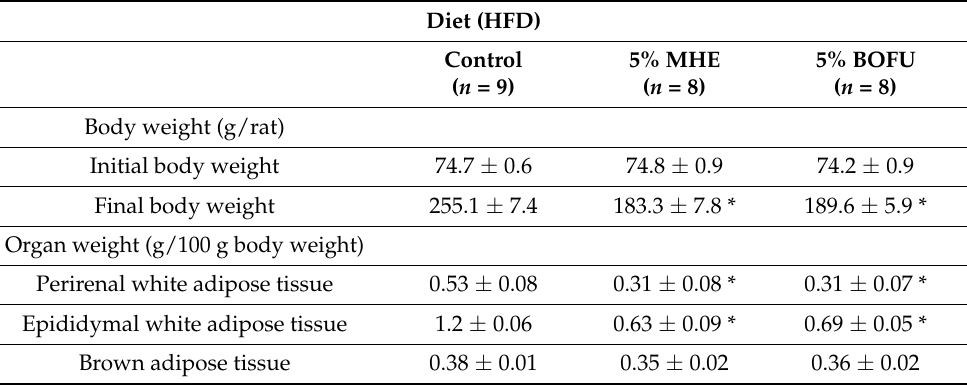
Table 7. Effects of MHE and BOFU on body and organ weight after four weeks of